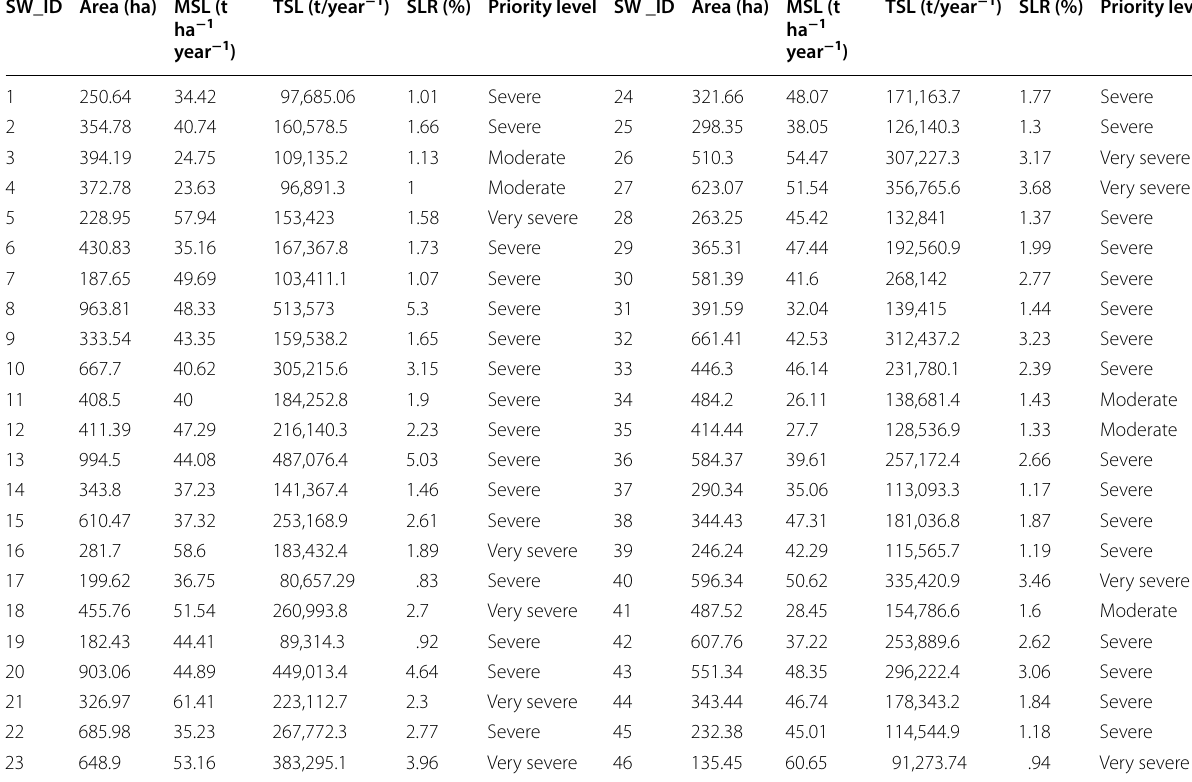
MSL, mean soil loss; TSL, total soil loss; SLR, soil loss ratio; SW_ID, sub-Watershed identification number (SW1, SW2, SW3, …